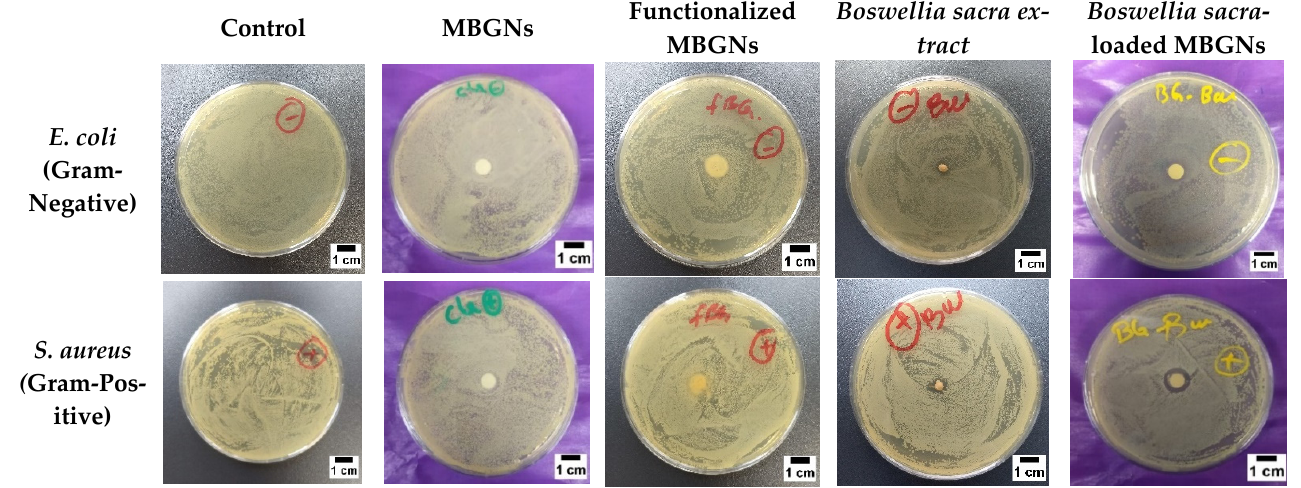
Figure 7. Optical images of agar plates after 24 h of incubation for different studied